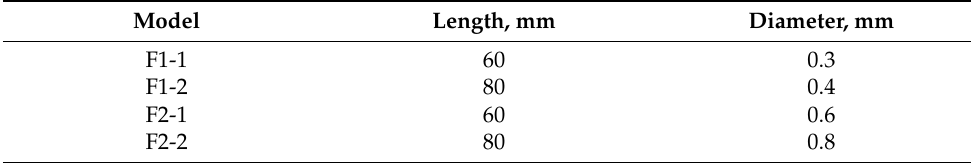
Table 2. Dimensions of